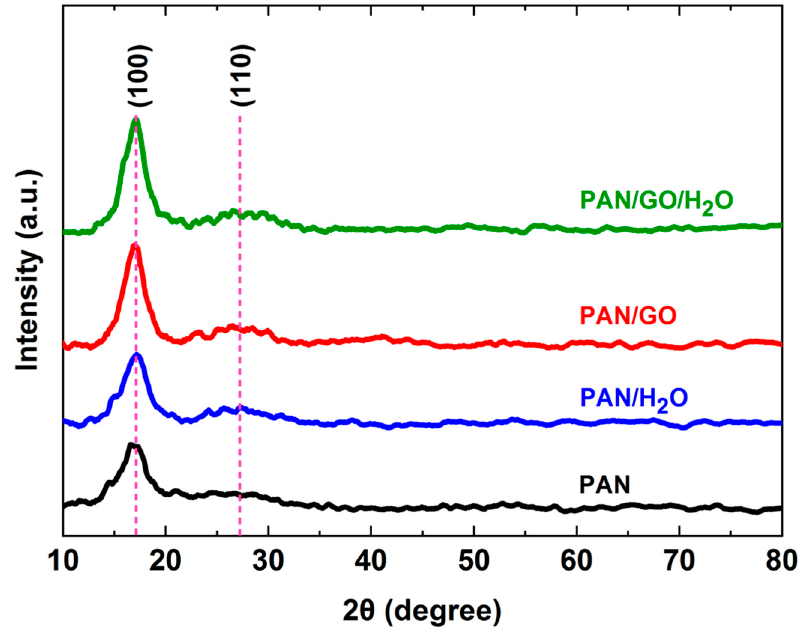
Figure 5. XRD patterns of PAN-based fibers.